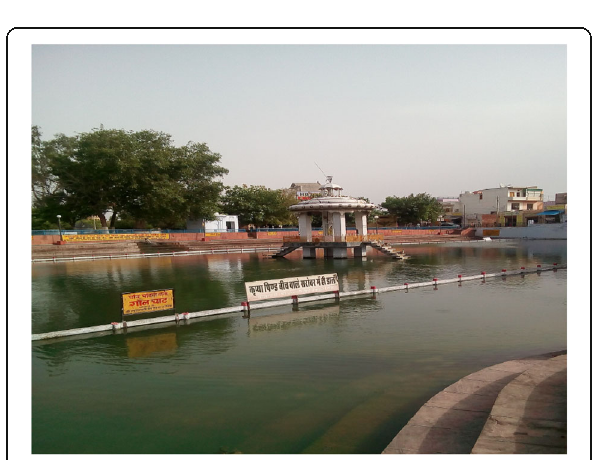
Fig. 2 Photograph of Prithus